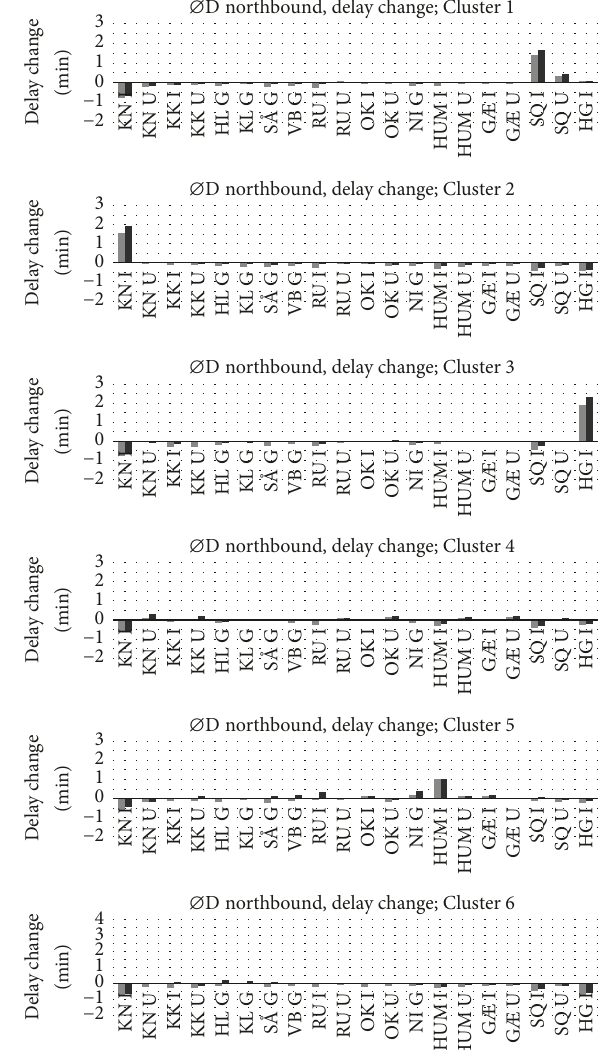
Figure 6: Delay changes recorded for ØD northbound train, by clusters. Median in bright shade and average in dark shade.